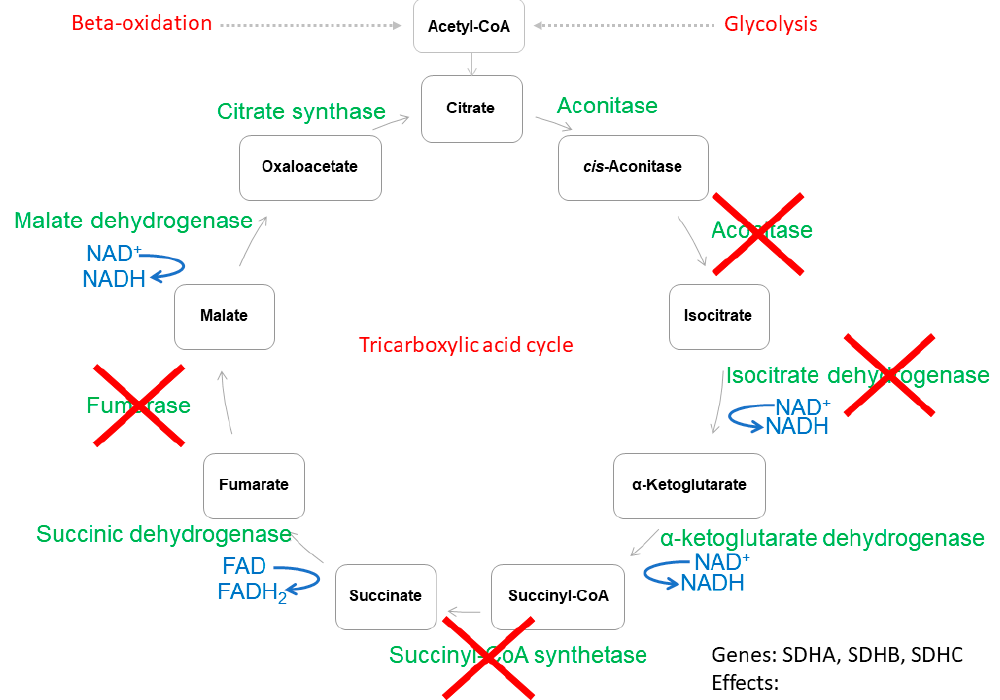
Figure 2. The tricarboxylic acid cycle and common enzyme mutations. Colors: red crosses show inactive enzymes (green), nucleotides (blue), metabolites (black). Each red-crossed enzyme has a comment with the name of the gene being mutated and the metabolic outcomes rising from such mutation. Please note that this figure reports only alterations in genes encoding mitochondrial enzyme isoforms.